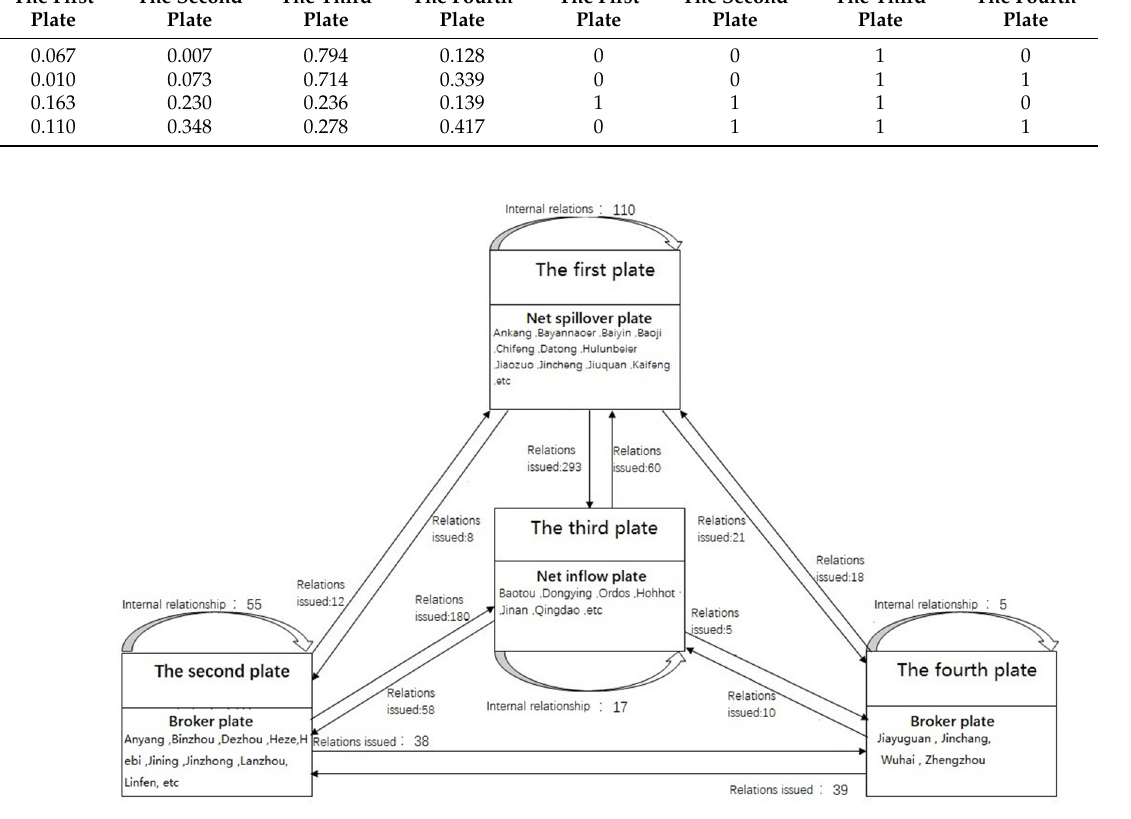
Figure 8. Correlation diagram of the four plates.